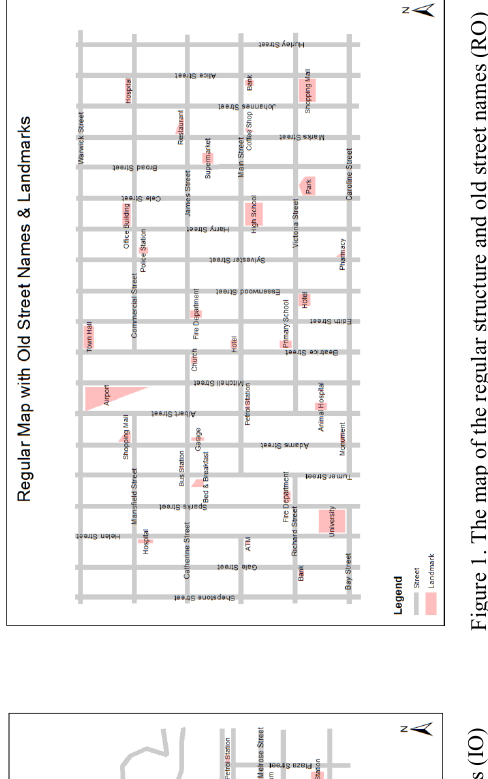
Table 1. Summary of the route planning tasks as presented to participants and maps provided Regular street